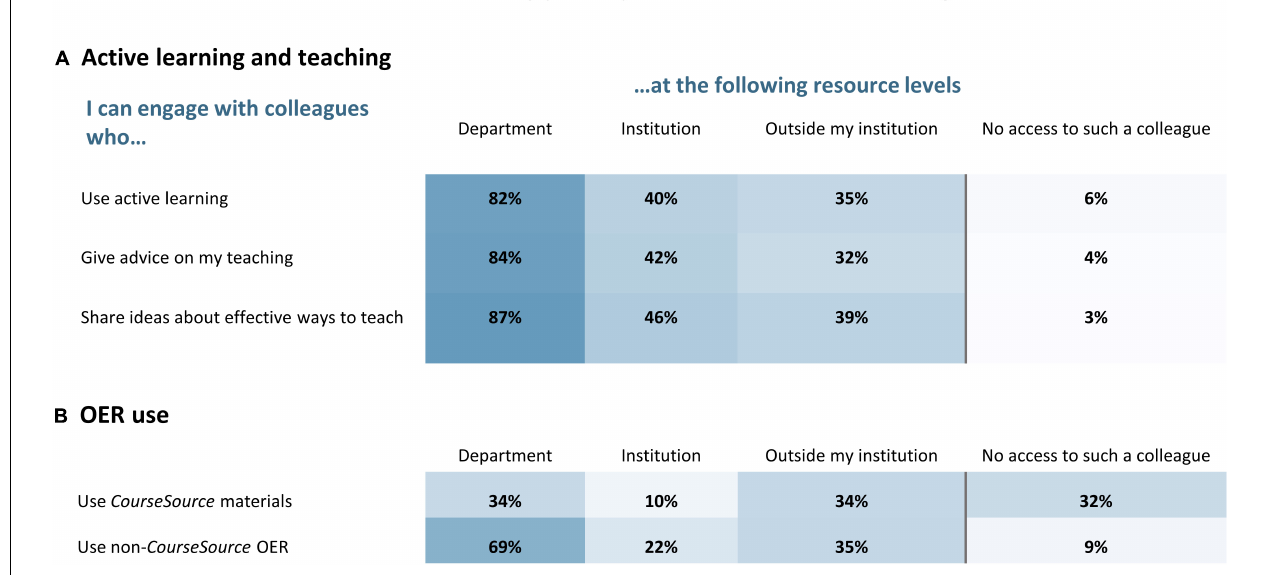
FIGURE 2 | Survey participants’ access to colleagues at the department, institution, and outside institution levels based on (A) active learning and teaching advice and (B) OER use including CourseSource materials. The background color of the box is correlated with the frequency of choice.